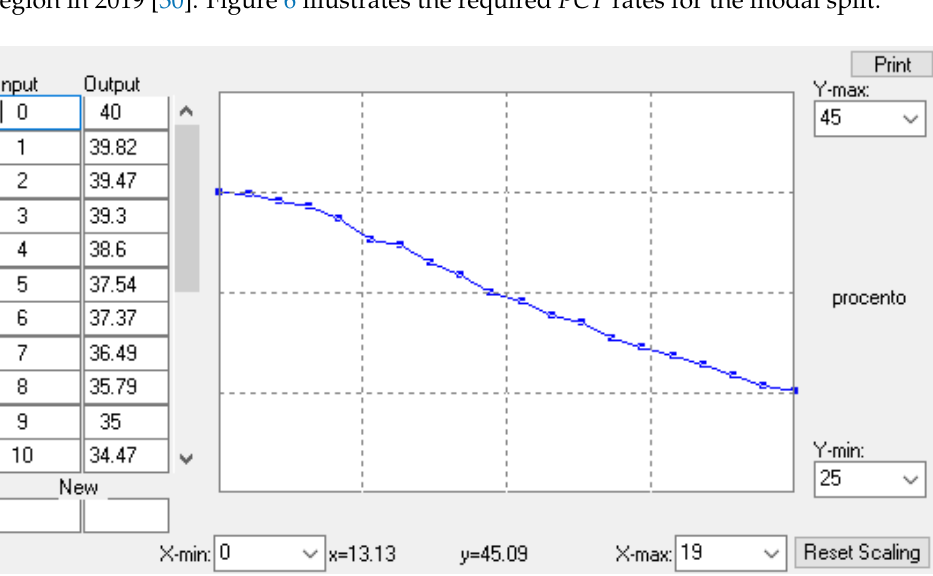
Figure 6. Vensim software: graphical depiction of the expected trend of PT rates for residents’ demand for travels.